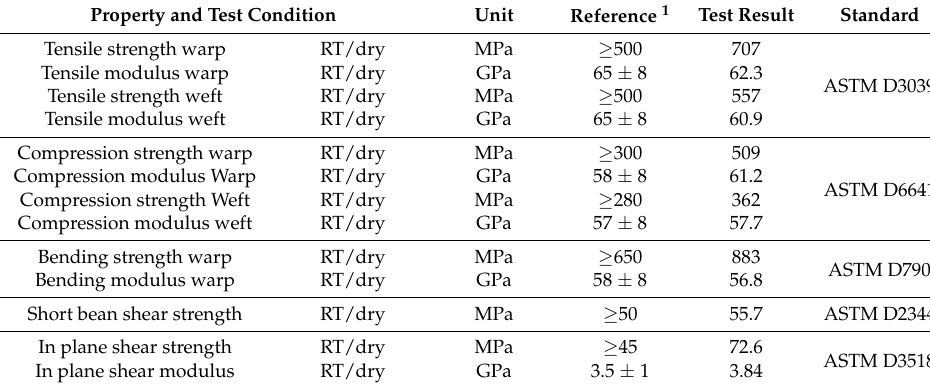
Table 2. Mechanical properties of AGMP3600/CW3011 (carbon fiber plain weave, 200 g/m 2 , 57 vol %), a rosin-epoxy laminate, and a corresponding reference laminate for comparison.